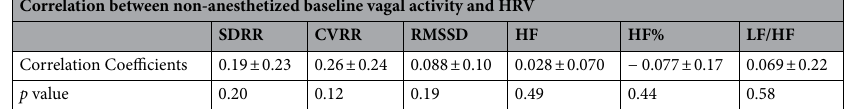
Table 2. Correlations of non-anesthetized baseline vagal activity with HRV. Data shown are the averages for four animals (358 total recordings). None of the six HRV metrics have correlations significantly different from zero (Bonferroni corrected significant level of p = 0.0083). Supplemental Table 2 shows individual correlations and p values for each animal.